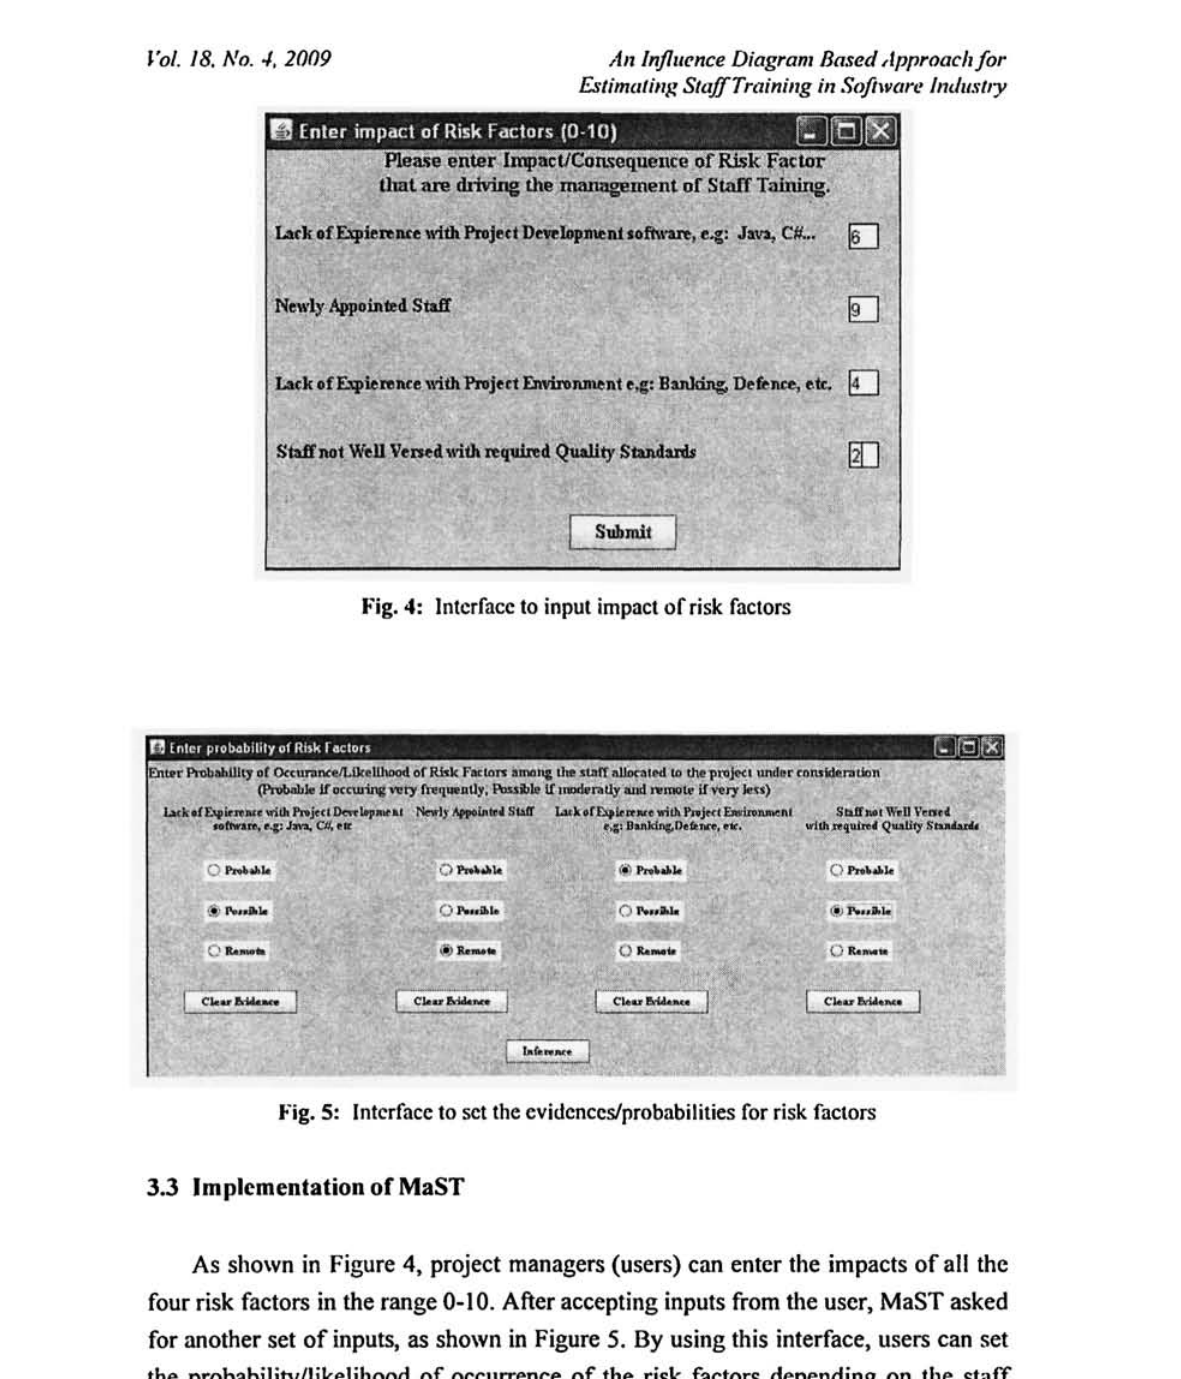
Fig. 5: Interface to set the evidences/probabilities for risk